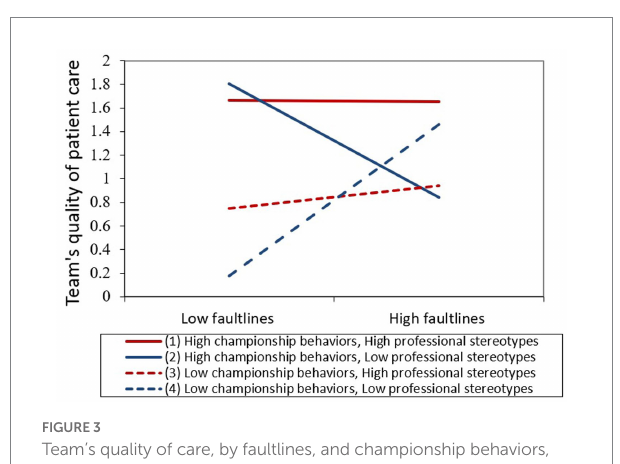
FIGURE 3 Team’s quality of care, by faultlines, and championship behaviors, and professional